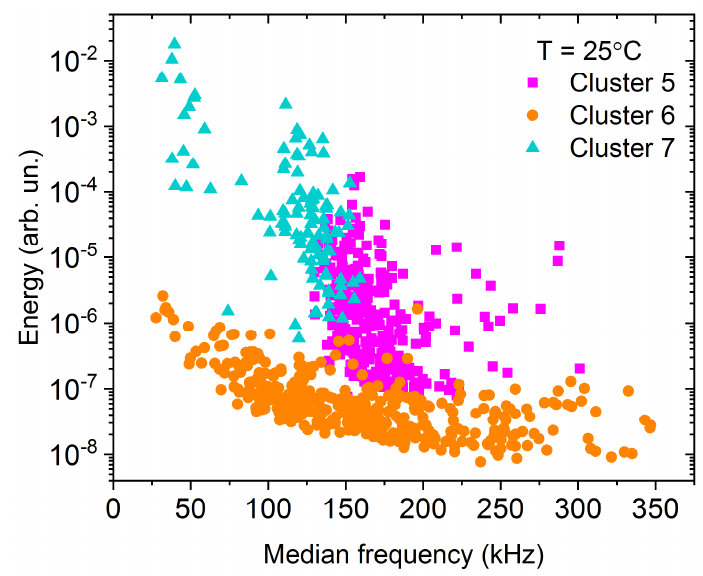
Figure 4. Energy—median frequency feature space for the measurement at 25 °C.